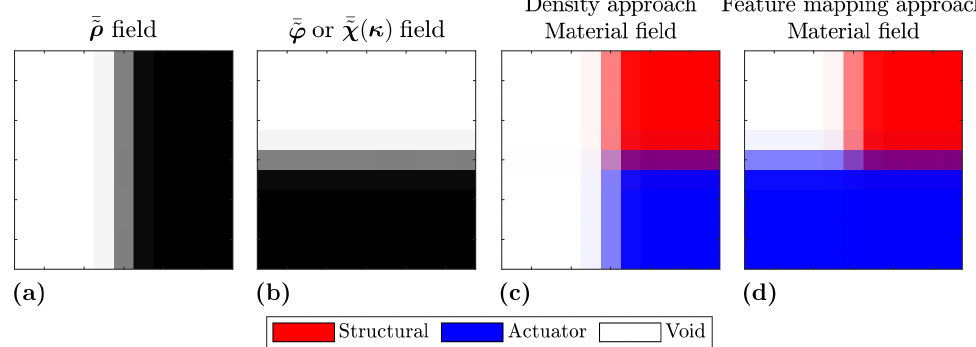
Figure 3. Illustration of the two density fields and two material fields. ( a , b ) show the density fields. ( c ) shows how the material model is realized for the density approach. ( d ) shows how the material model is realized for the feature-mapping approach; notice how the actuator material is dominating the material field when realizing the material model. As seen in ( c , d ), red material defines the structural material, while blue material defines the actuating